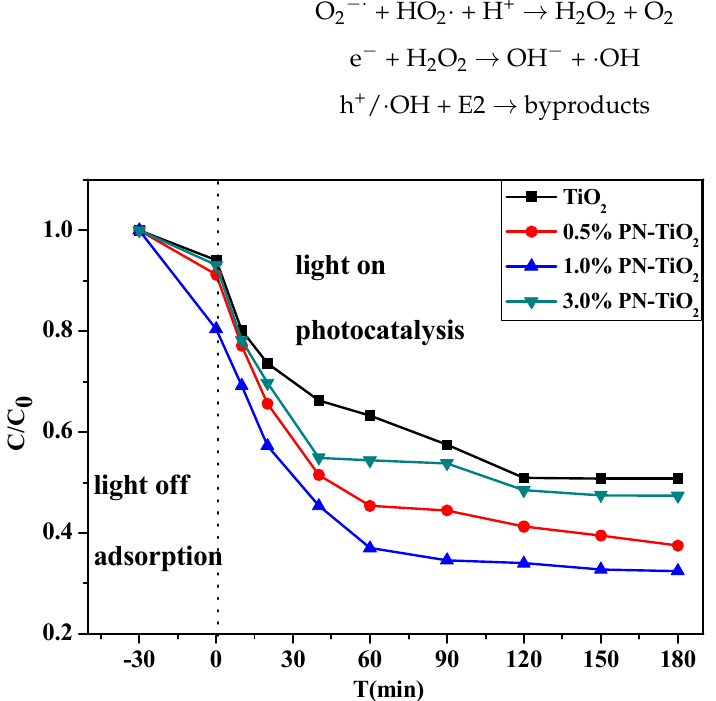
Figure 7. Photodegradation efficiency of different PN-TiO 2 composites. (t < 0 and t > 0 denoted dark adsorption and light photodegradation, respectively).